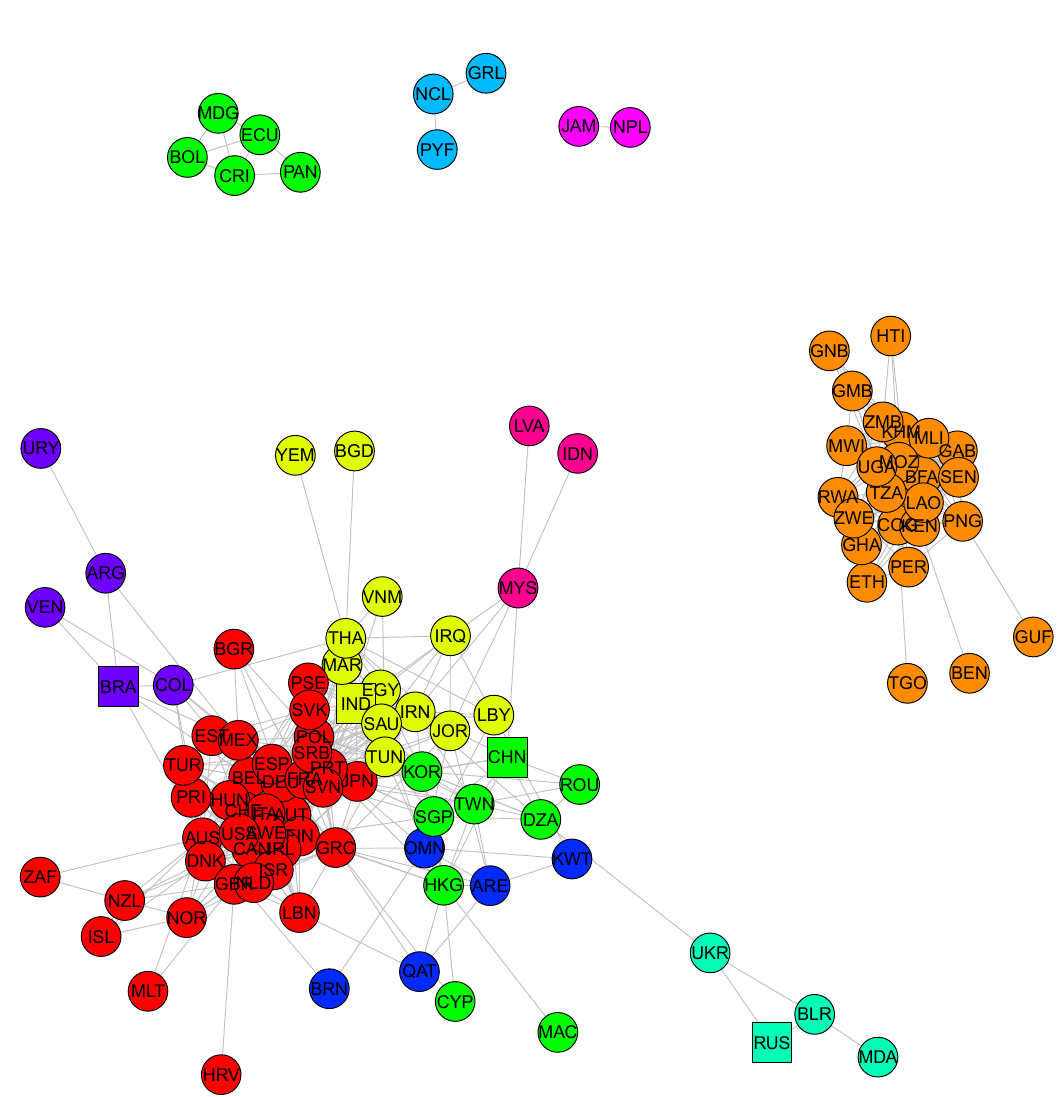
Figure 2. Network visualization of similarities between 111 countries according to publishing patterns. Similarity was computed using cosine similarity function. Links below 0.895 were eliminated just like isolated countries. Colors were assigned according to communities automatically detected by the algorithm Infomap [24]. Nodes corresponding to BRIC countries are highlighted with squares. Country codes are defined according to the standard ISO 3166-1 alpha-3 codes. A list of communities and their corresponding countries has been included in Appendix A.